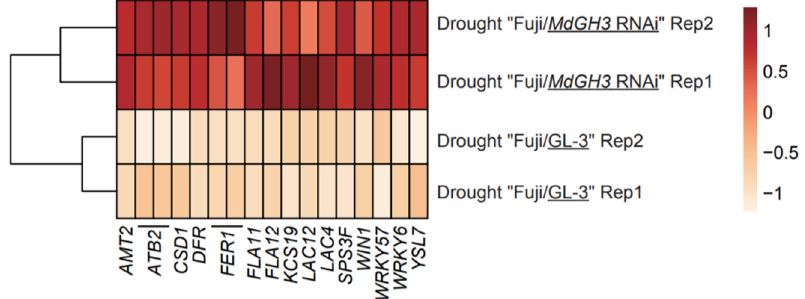
Figure 5. Heatmap of expression levels (in the form of z-score fragments per kilobase of transcript per million fragments mapped) showing the stress and growth-related DEGs in rootstock obtained by comparing drought-treated “Fuji/ MdGH3 RNAi” plants to drought-treated “Fuji/GL-3” plants.